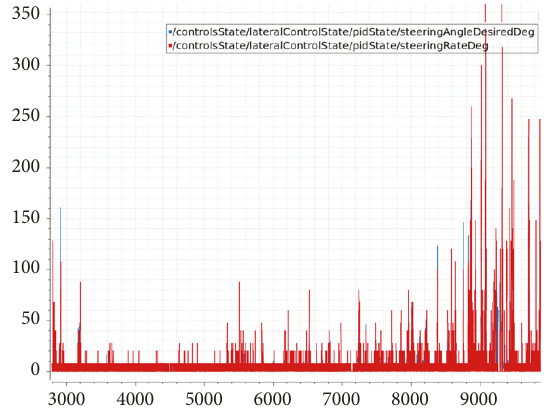
Figure 47: T2D2 steering degrees.